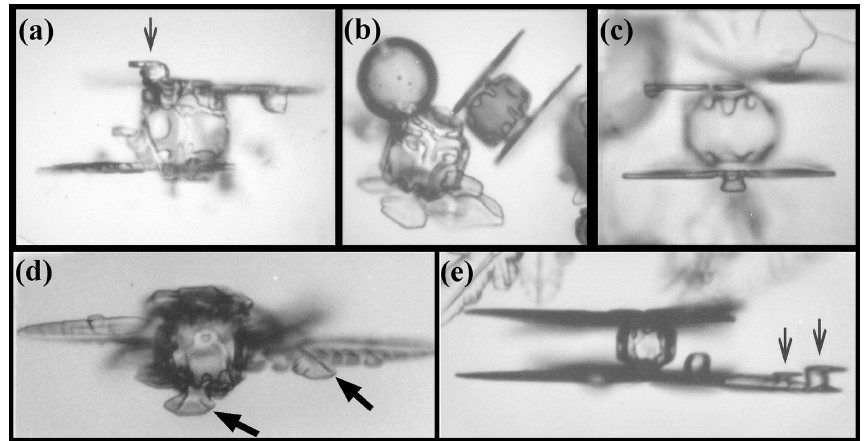
Figure B3. Protruding growth on large droxtals ( ∼ 40–70µm) to form the two-level structure near − 15 ◦ C and liquid-water saturation. Black arrows in (a) and (e) show protruding growth on smaller rime droxtals. Black arrows in (d) shows complex structure of branch and sidebranch backside. (From the cloud chamber, courtesy of Akira Yamashita.)